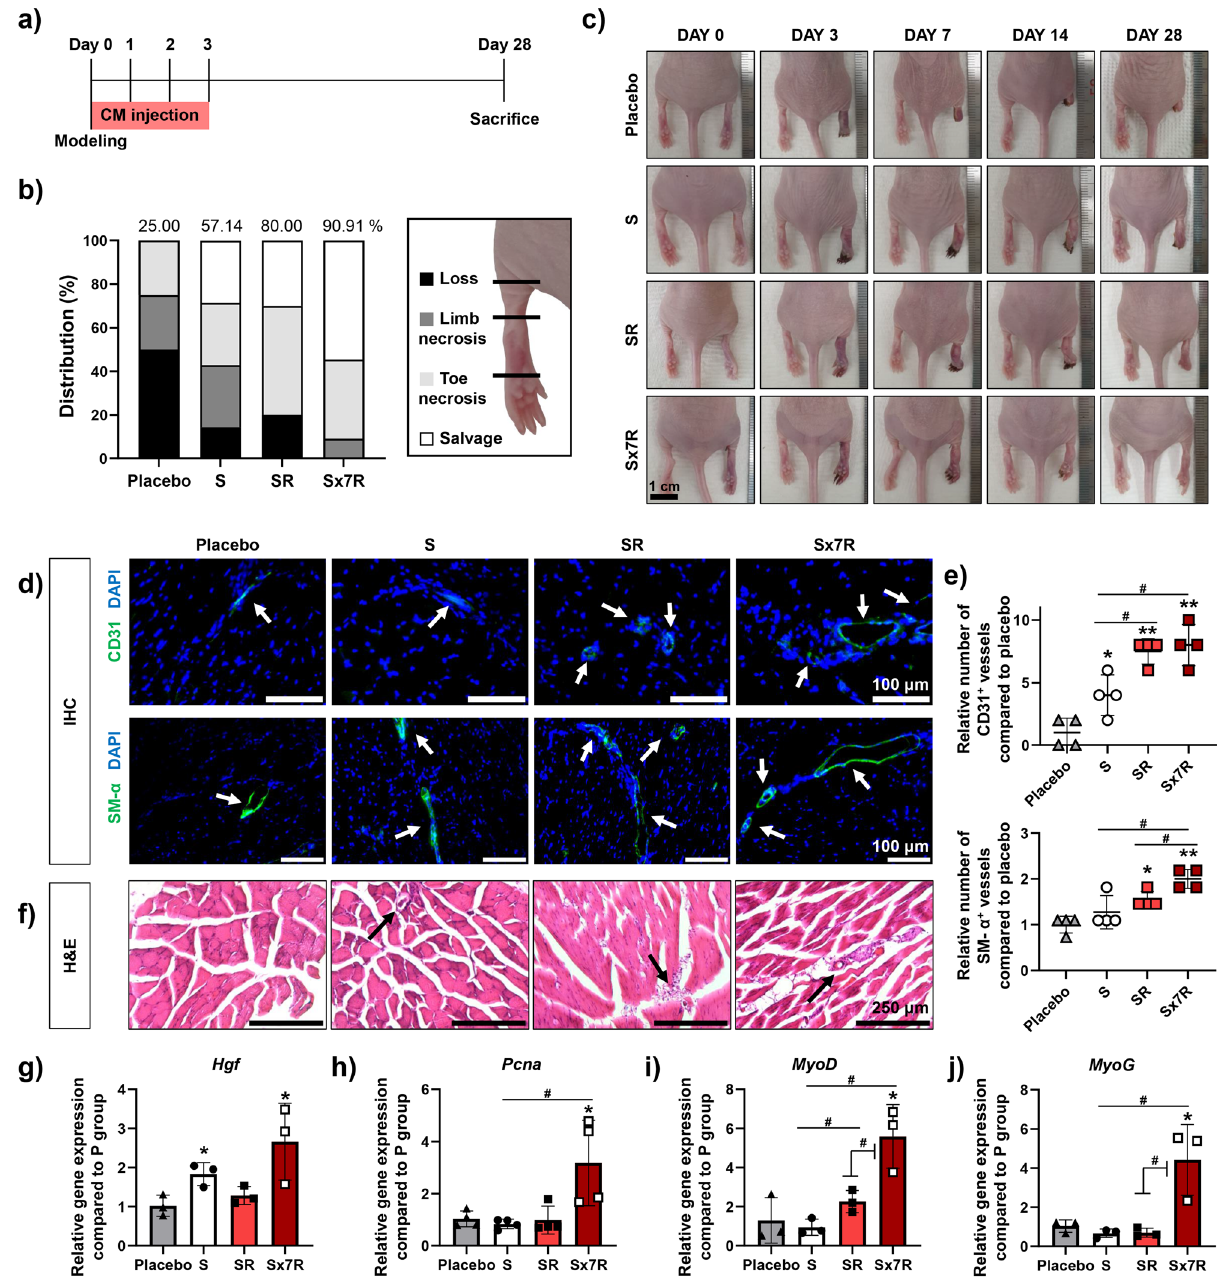
Fig. 6 Treatment of hindlimb ischemic disease using conditioned medium (CM) collected from Sx7R. a Schedule of in vivo experiment. b Physiological status of hindlimb ischemia 28 days after the various treatments. c Representative photographs of limbs in each group at 0, 3, 7, 14, and 28 days after various treatments. d IHC images of CD31 or SM- α -actin expression (green fl uorescence) and DAPI (blue) staining in the hindlimb regions on day 28 (Scale bar = 100 μ m: white arrows indicate vessels). e Relative number of CD31 + and SM- α + vessels in the hindlimb regions on day 28 ( n = 4, * p < 0.05 vs. Placebo group, ** p < 0.001 vs. Placebo group, # p < 0.05 vs. each group). f Representative images of H&E staining in the hindlimb regions on day 28 (Scale bar = 250 μ m: black arrows indicate blood vessels). Relative expression of g Hgh , h Pcna , i MyoD , and j MyoG in the hindlimb regions on day 28 ( n = 3, * p < 0.05 vs. Placebo group, # p < 0.05 vs. each group). Data are presented as mean ±